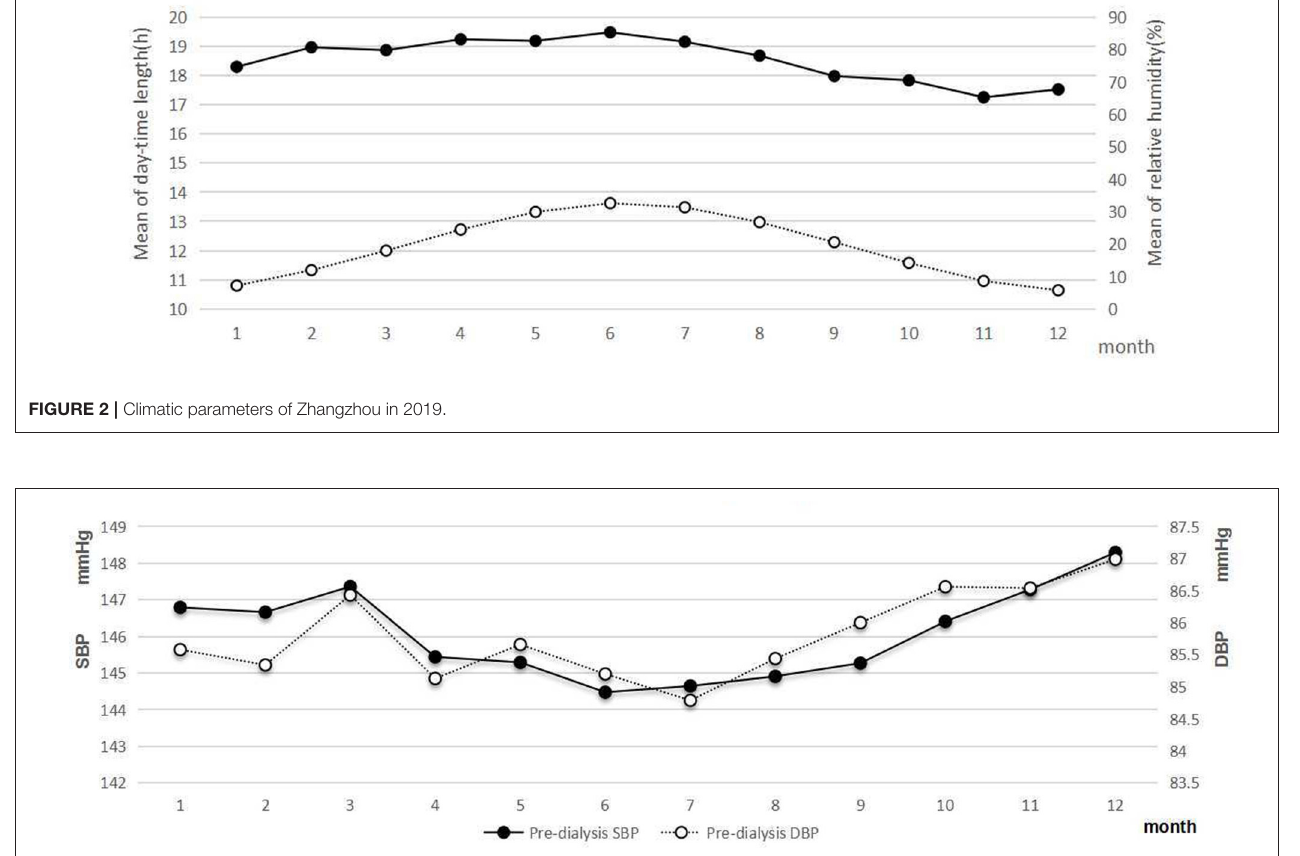
Frontiers in Cardiovascular Medicine |